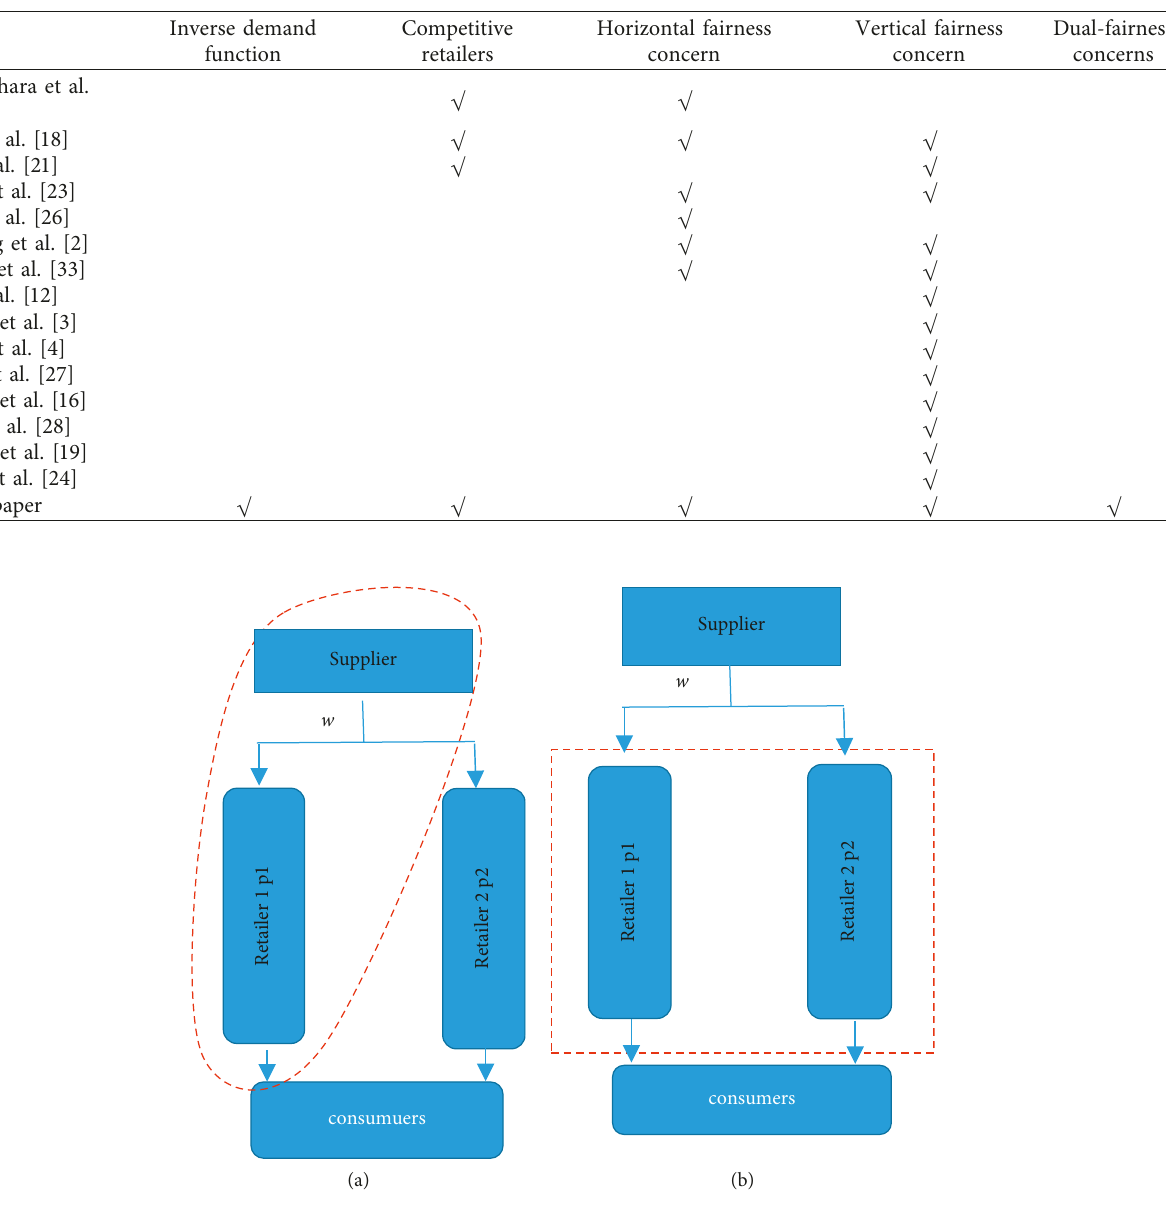
Table 1: Comparison of related references.